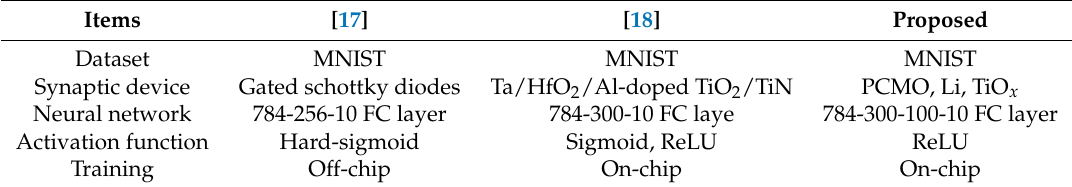
Table 1. Comparison of the previous and proposed